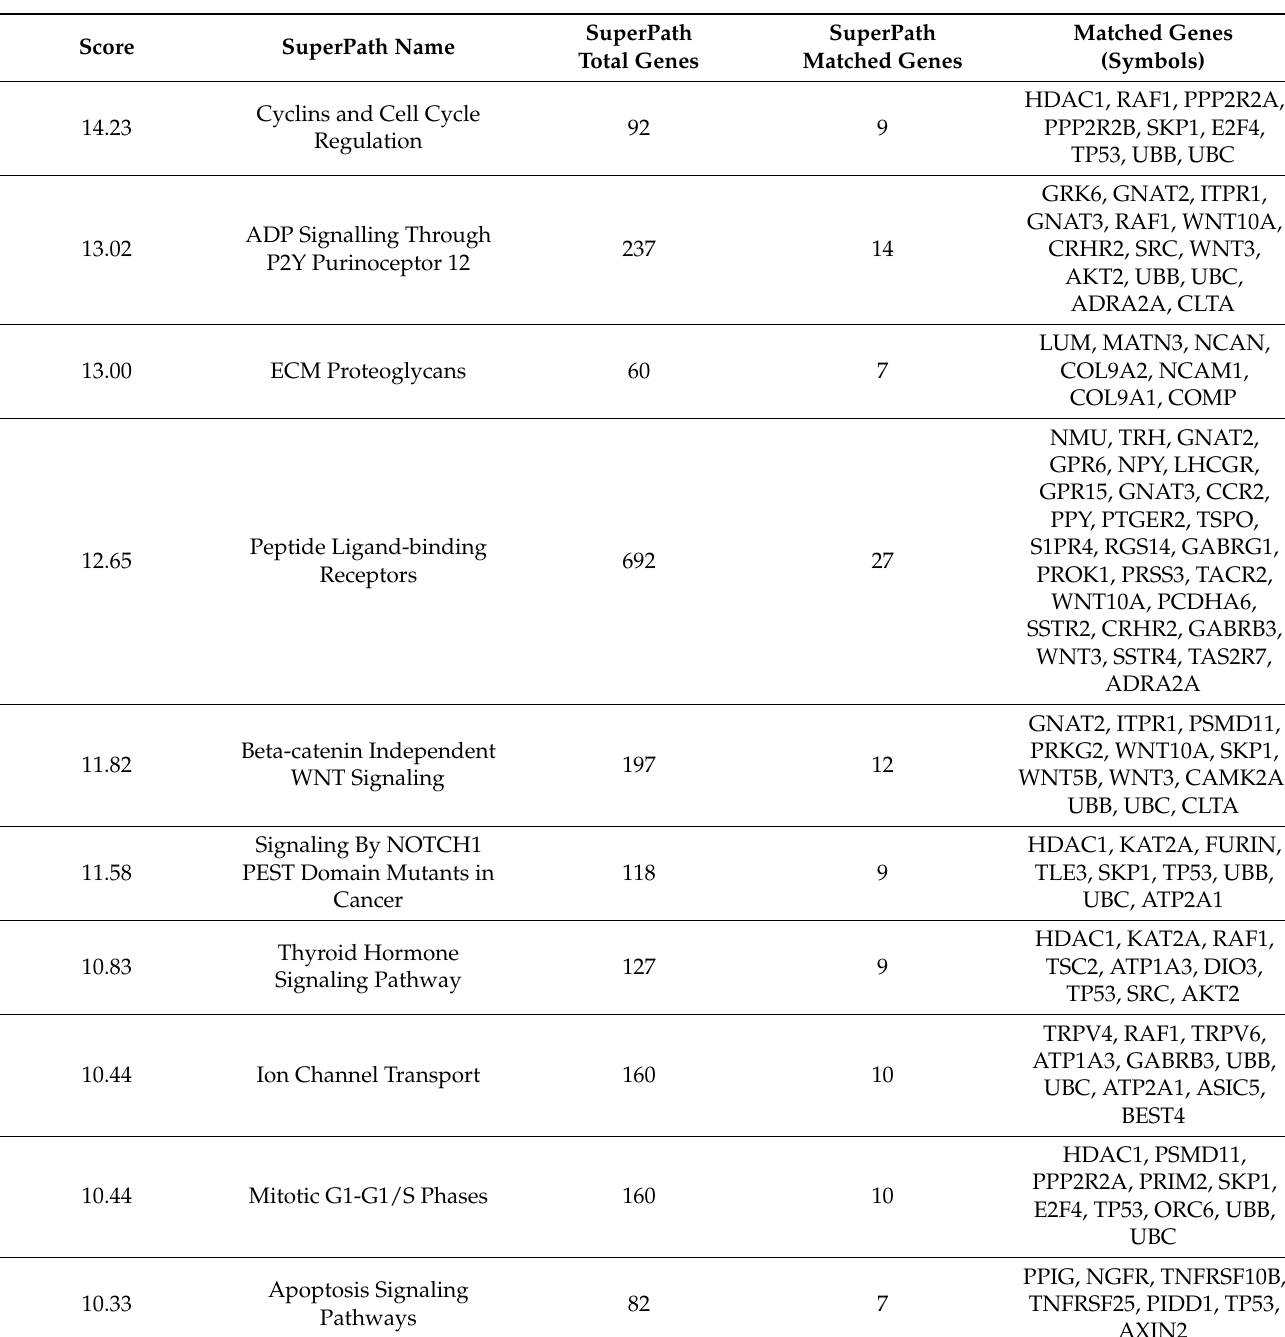
Table 6. Significantly enriched pathways 1 for production